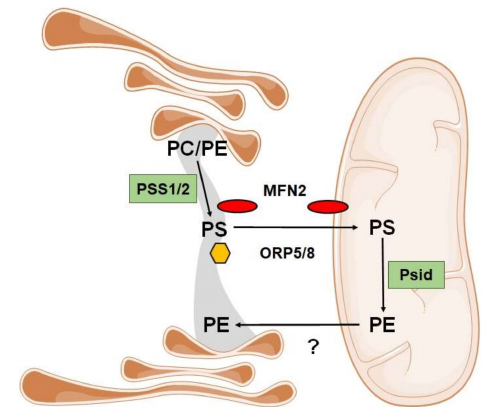
Figure 1. ( A ) Triglycerides (TAG) are synthetized by lipogenesis in the endoplasmic reticulum (ER) by esterification of three fatty acids with one molecule of glycerol. Lipids and enzymes (ER panel from left to right): FAs, fatty acids; FA-CoA, fatty-acyl-CoA; GPAT, glycerol-3-phosphate acyltransferase; LPA, lysophosphatidic acid; AGPAT, 1-acylglycerol-3-phosphate acyltransferase; PA, phosphatidate; PAP-1, phosphatidic acid phosphate; DAG, diacylglycerol; DGAT diacylglycerol acyltransferase. ( B ) Phospholipid synthesis de novo in mammalian cells takes place between the endoplasmic reticulum by the cytidine diphosphate (CDP)–Kennedy pathway and in mitochondria-associated membranes (MAMs), as discussed in the text. Phospholipids and enzymes from upper to bottom panel: P-C, phosphocholine; P-E, phosphoethanolamine; Pcyt1, choline-phosphate cytidylyltransferase; PCyt2, ethanolamine-phosphate cytidylyltransferase; PS, phosphatidylserine; PC, phosphatidylcholine; PE, phosphatidylethanolamine; PSS1, PS synthase-1; PSS2, PS synthase-2; PEMT1, phosphatidylethanolamine N(PEN)-methyl transferase; Psid, mitochondrial phosphatidylserine decarboxylase.